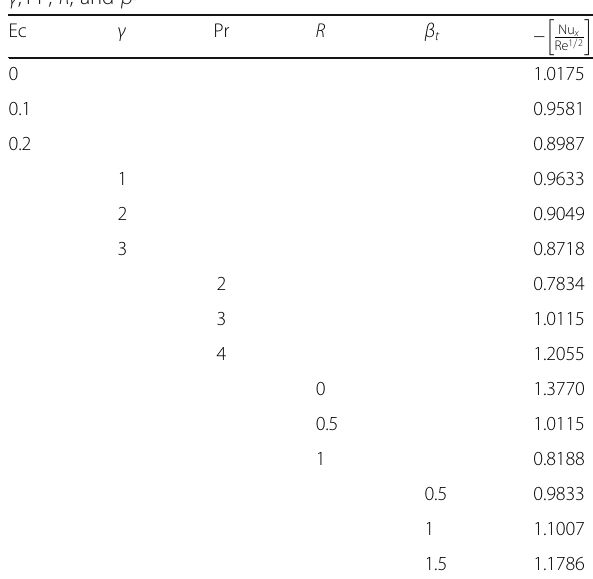
h i for different values of Ec, Re 1 = 2